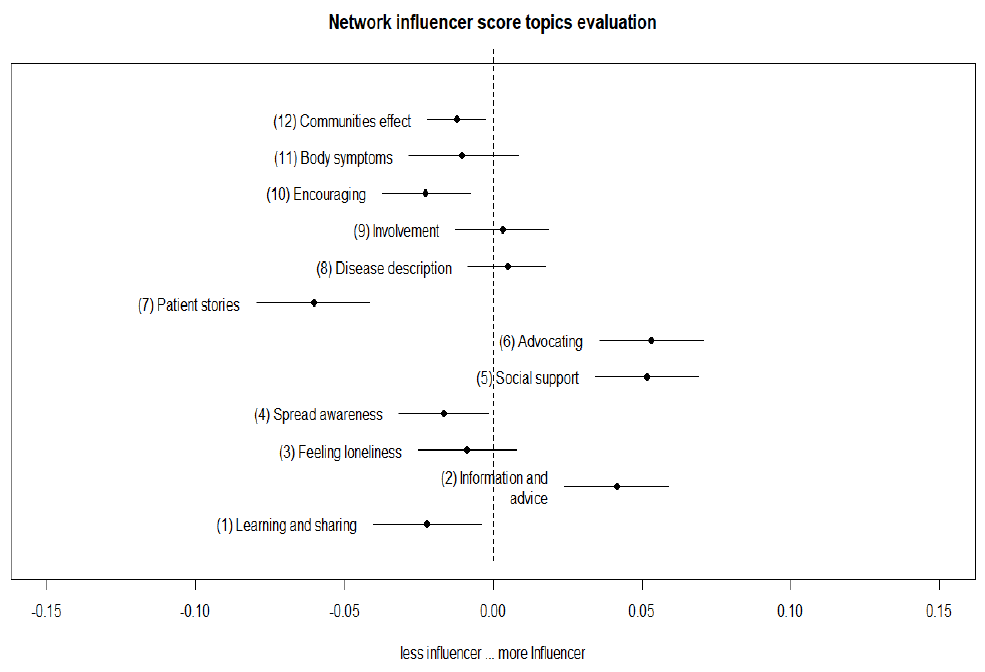
Figure 5. Estimated topic proportion to be discussed by network influencer.